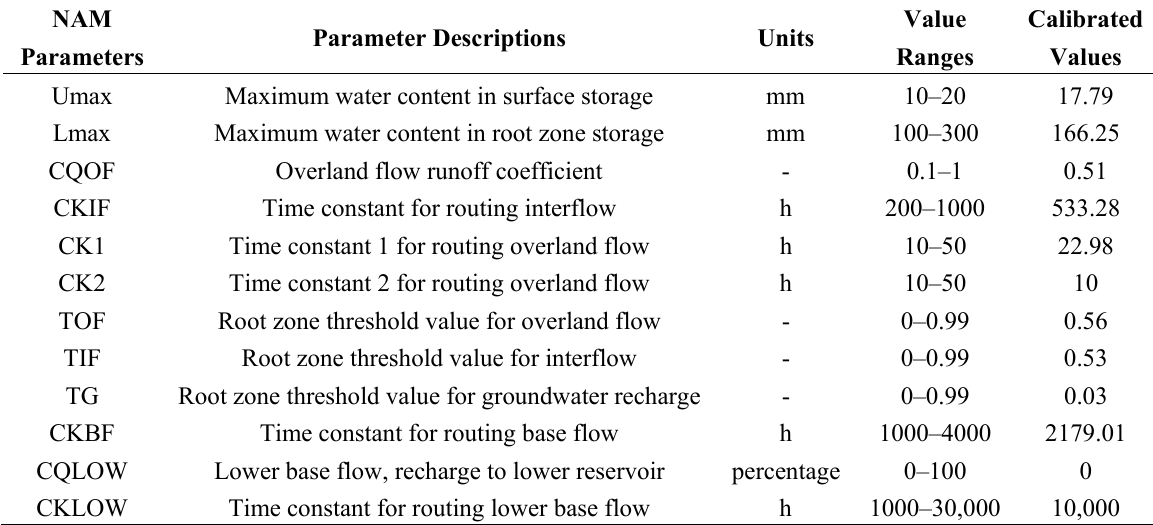
Table 3. Important parameters for NAM automatic